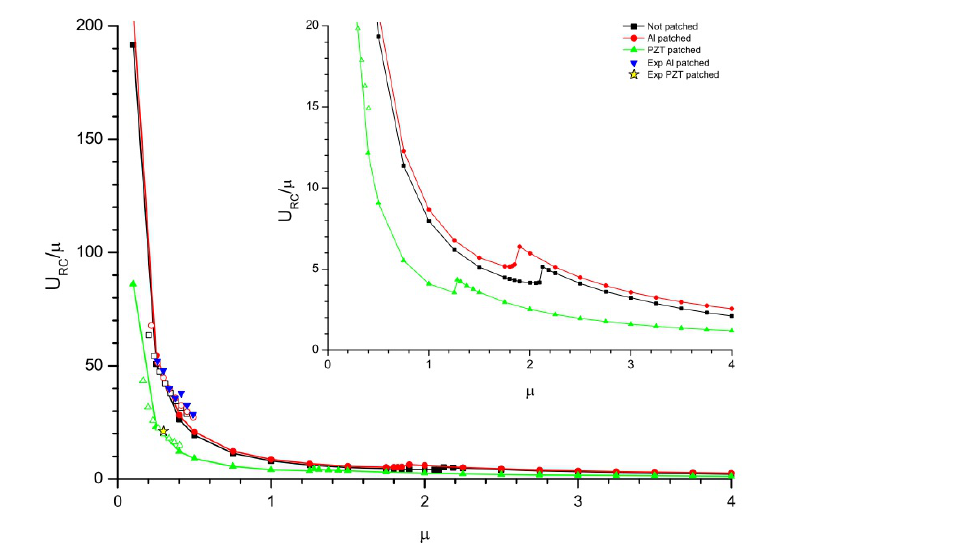
Figure 12. Flutter for reduced critical velocity; where µ = ρ F L / ρ S t and U RC / µ = (cid:104) (cid:16) (cid:17)(cid:105) ( ρ ) 3/2 / U ρ F D 1/2 P h